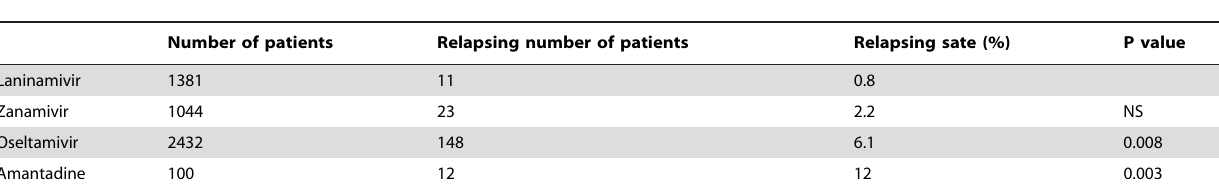
Table 5. Relapsing rate of influenza-like